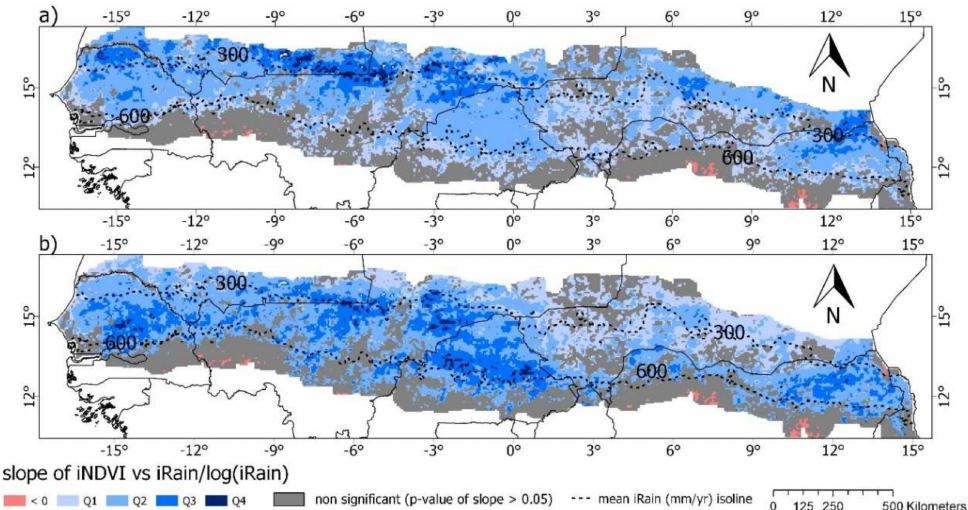
Figure 4. Relationship between i NDVI and i Rain: ( a ) linear model, ( b ) log-linear model. To facilitate direct comparisons of linear and log scale, positive slope values from both models have been classified using equal interval ranges from Q1(lowest quarter—significant but weakest relationship) to Q4 (highest quarter—significant and strongest